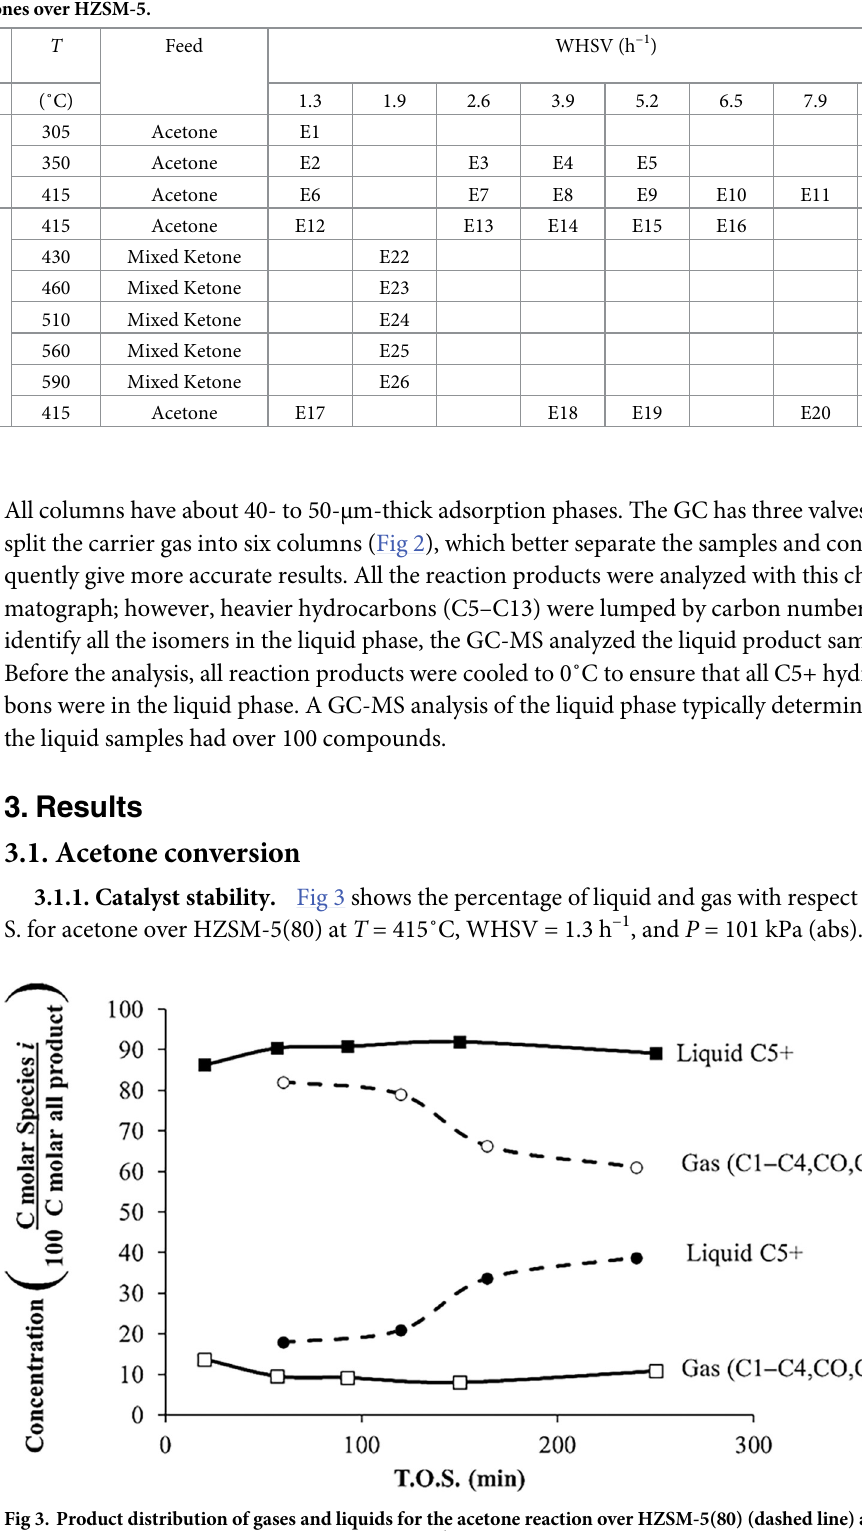
Table 1. Experiments for acetone and mixed ketones over HZSM-5.